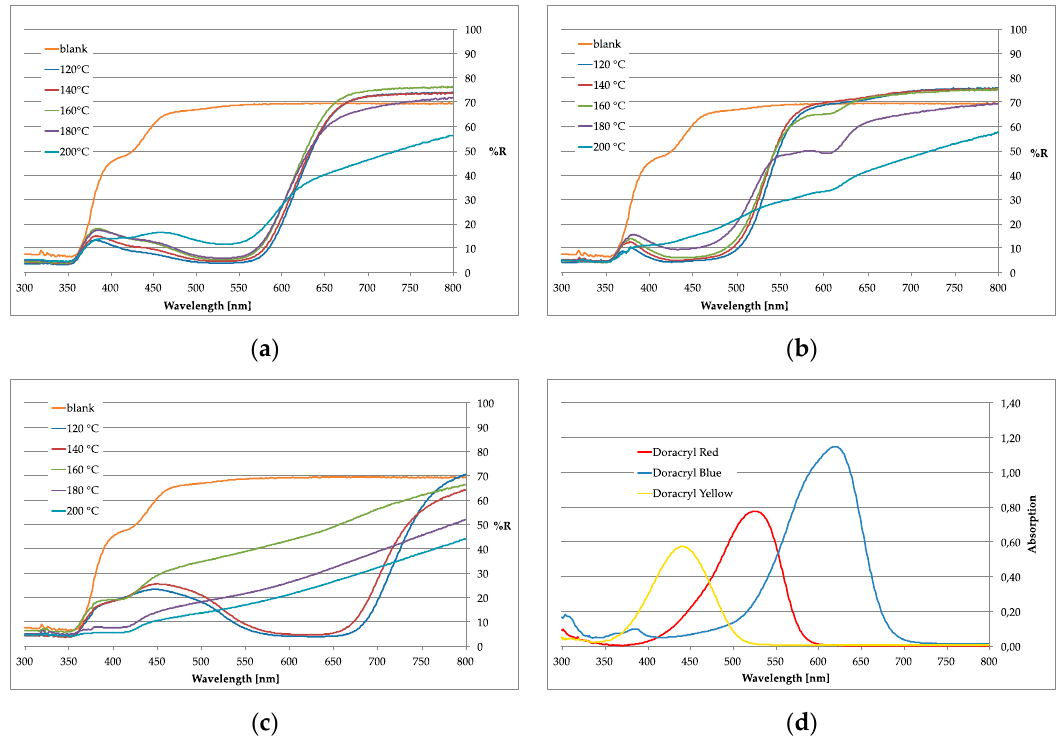
Figure 5. UV–Vis remission spectra of aramid fabrics after dyeing with various cationic dyestuffs in EMIM-EtSO 4 at different temperatures; ( a ) Doracryl Red; ( b ) Doracryl Yellow; ( c ) Doracryl Blue; ( d ) UV–Vis absorption spectra of the pure dyestuffs.